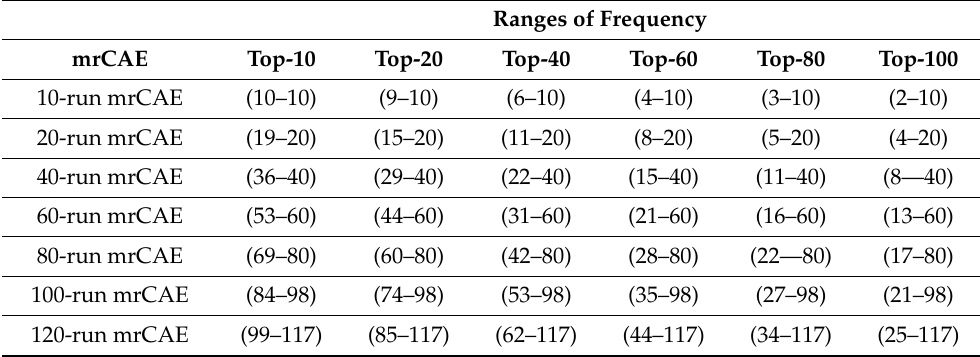
Figure 4. For example, combining six sets of top-10 features from 10-, 20-, 40-, 60-, 80-, and 100-run mrCAE systems produced a unique list of 14 lncRNAs.